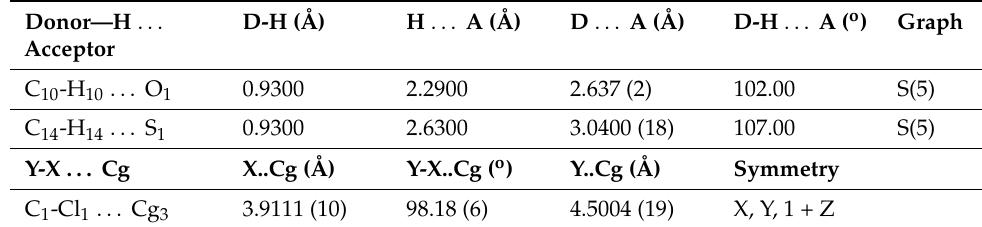
Table 2. Hydrogen bonds and Y-X…Cg interaction for compounds 15 .